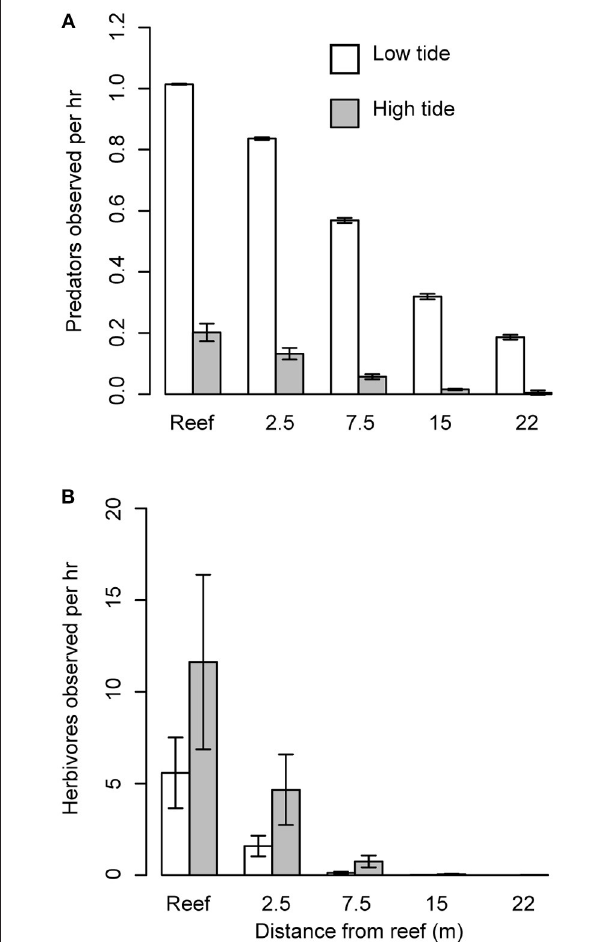
FIGURE 2 | Effect of predators on herbivore abundance. (A) Mean number ( ± s.e.) of predators observed per hour in Heron lagoon during high and low tide on the reef and with increasing distance from patch reef edge. (B) Mean number ( ± s.e.) of herbivores observed per hour in Heron lagoon during high and low tide and with increasing distance from patch reef (i.e.,